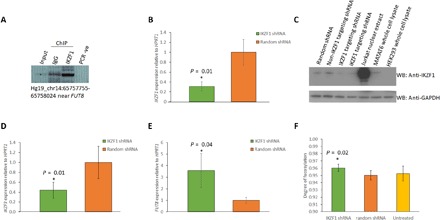
Results of in vivo validation of the functional links between IKZF1 and FUT8.(A) IKZF1 binds to a regulatory region upstream of FUT8. (B) Knockdown of IKZF1 leads to decreased expression of IKZF1 (n = 3). (C) Representative Western blot showing that IKZF1 is depleted at the protein level (protein reduced by around 50% compared with a random shRNA line or a non-IKZF1 targeting shRNA line). WB, Western blot. (D) Knockdown of IKZF1 leads to decreased expression of IKZF3 (n = 3). (E) Knockdown of IKZF1 leads to increased expression of FUT8 in the LCL (n = 3). (F) There is a small but significant increase in fucosylation of IgG secreted by the LCLs in which IKZF1 is knocked down (n = 3 lines, measured at two time points). All P values are t tests, and error bars show SD from the mean. Asterisk indicates P value <0.05.